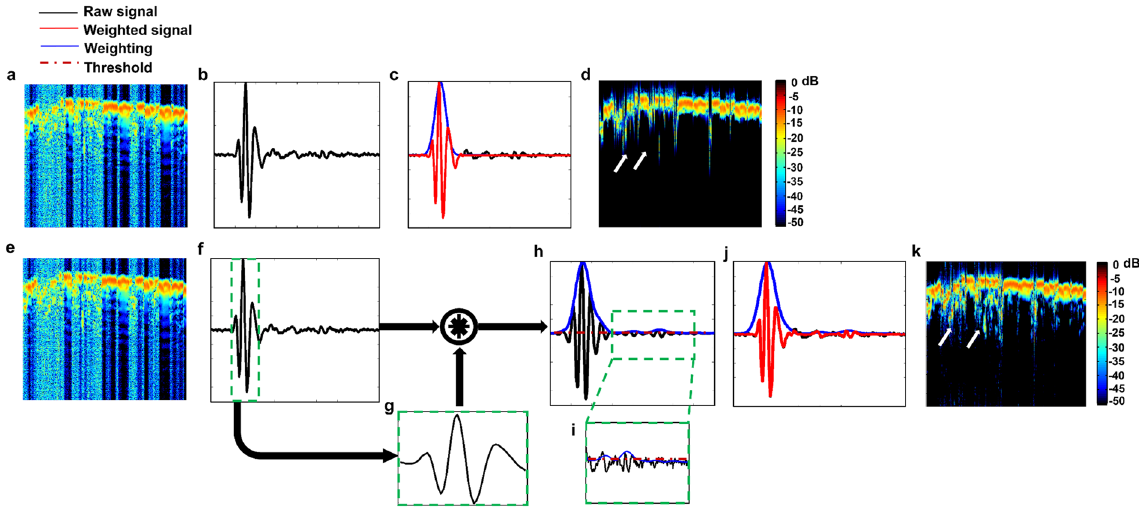
Figure 4. ( a , e ) Dictionary learned from B-scan ( b , f ) Representative atom ( c ) Maximum window weighted atom, ( d ) Maximum window weighted dictionary, ( g ) Signal of maximum intensity isolated from representative atom ( f ) (green box). ( h ) Cross correlation of ( f ) and ( g ). ( i ) Zoomed inset showing small signals retained under threshold ( j ) Correlation weighted atom ( k ) Correlation weighted dictionary. Purple line shows threshold, blue line shows weighting function, red line shows signal after weighting is applied and raw signal is shown in black.